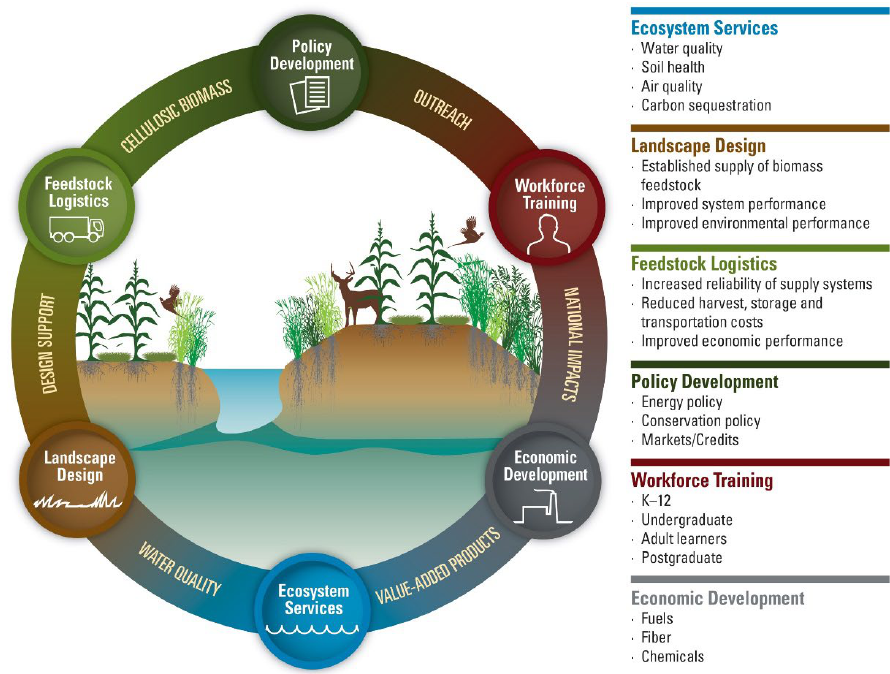
Figure 1. Conceptual representation of the Midwest sustainable biofuels vision. The prospect of integrating bioenergy crops into agricultural landscapes creates an opportunity to diversify cropping systems resulting in enhanced ecosystem services and economic development. (Drawing by Christine Hobbs, Hobbs Designs, LLC.)